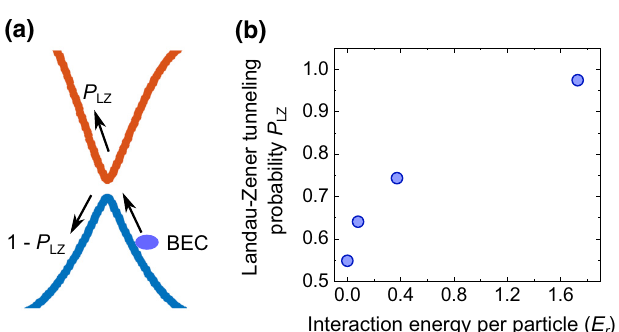
FIG. 11. Simulated effects of interparticle interactions on Landau-Zener tunneling. (a) Schematic showing atoms in the ground band tunnel to the excited band with a Landau-Zener tunneling probability of P LZ . (b) Calculated P LZ increases and eventually approaches 1 with increasing interaction energy per particle. In the simulation, 15 000 87 Rb atoms are prepared in a shallow 1D harmonic trap, where the trap frequency is 25 Hz. The single-particle gap size is 0.14 E r . Here dq y / dt = 0.188 K /ms.